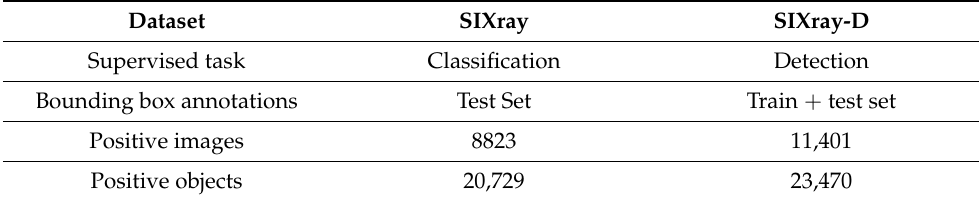
Figure 3. Negative images that are marked as positive by the detection network. Table 2. Comparison between SIXray [17] and SIXray-D